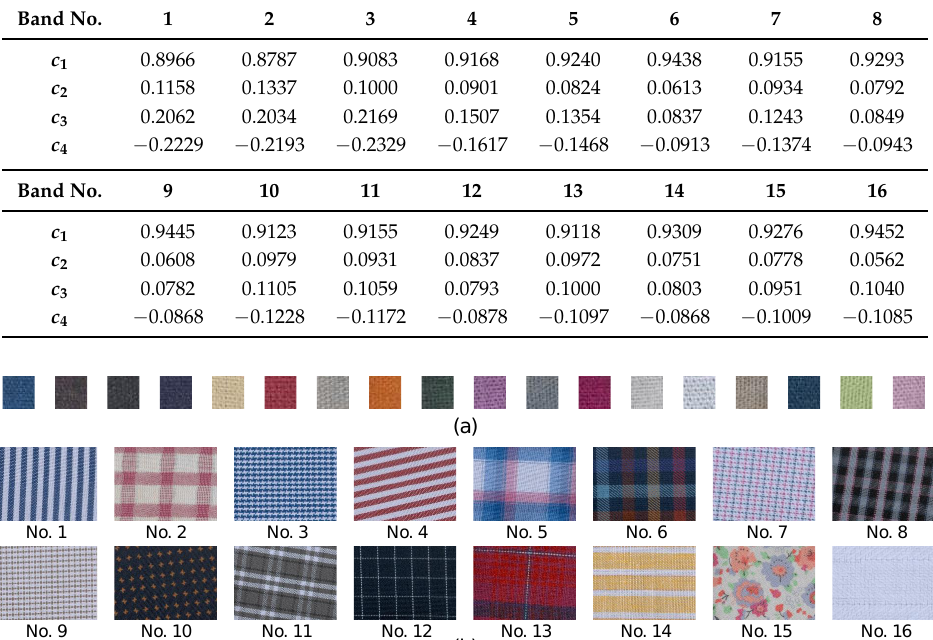
Table 2. The coefficients of the polynomial model obtained from the training data.